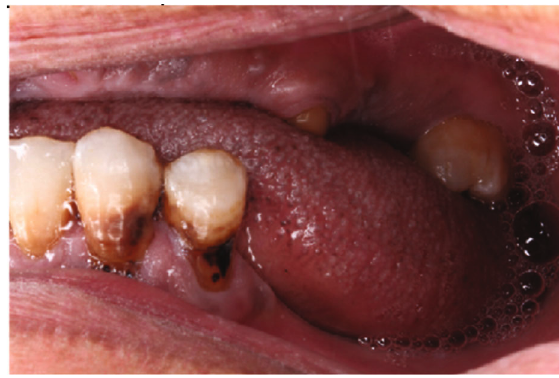
Figure 3: Preoperative left lateral view.